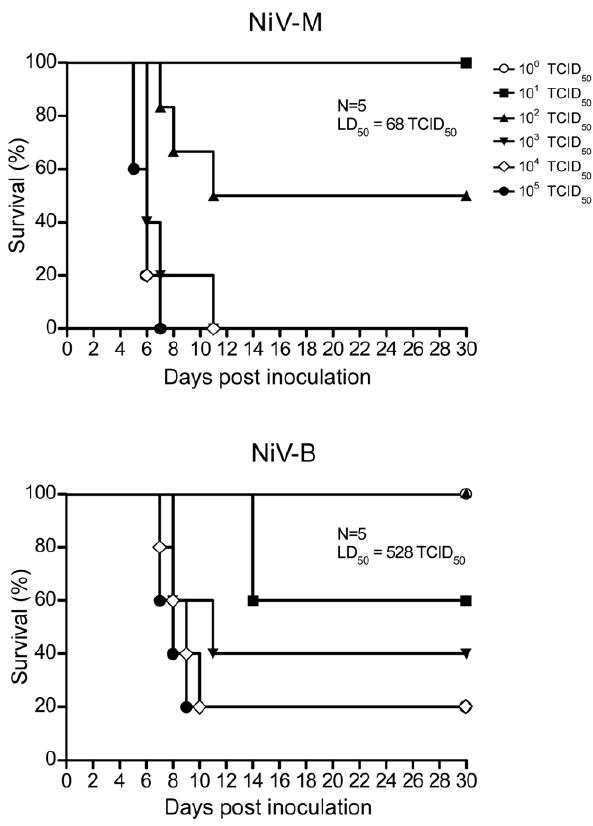
Figure 2. Hamsters inoculated with NiV-B show delayed disease progression compared to NiV-M-infected hamsters. Groups of 5 hamsters were inoculated i.p. with 10-fold serial dilutions of virus from 10 5 to 1 TCID 50 . The hamsters were monitored for 30 dpi for survival.